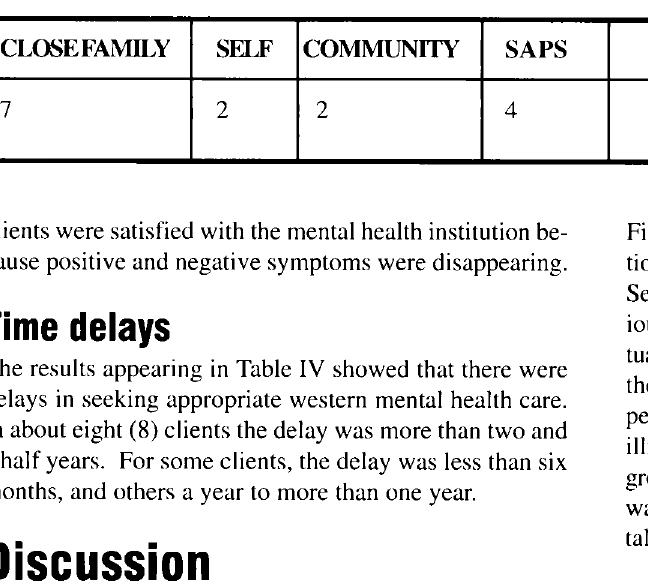
Table III: Decision-makers